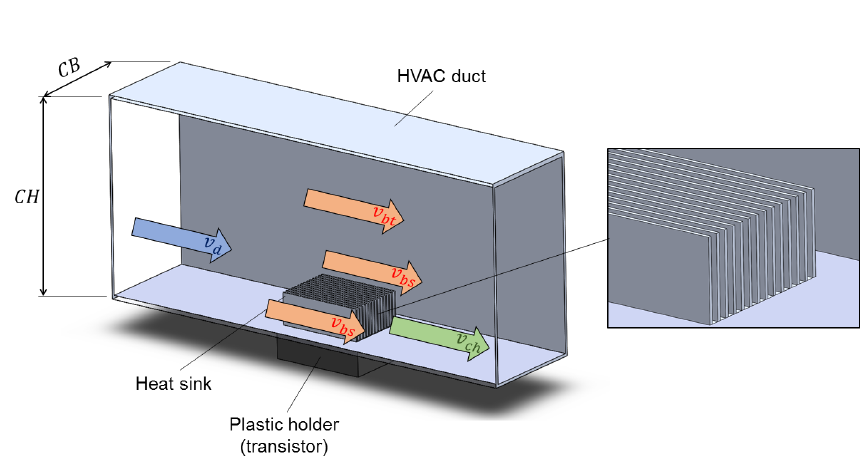
Figure 3. Scheme of the bypass phenomenon. Note that the heat sink is flush-mounted in a duct with CB × CH section, where CB and CH are channel base and height,